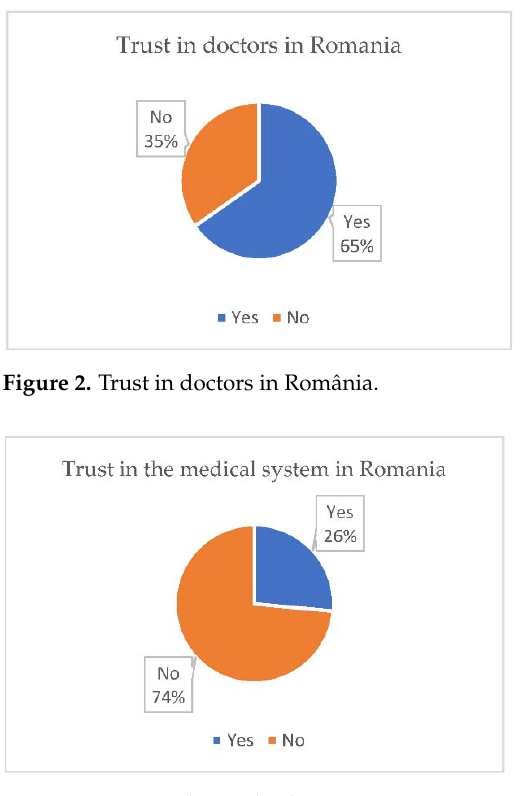
Figure 3. Trust in the medical system in România.